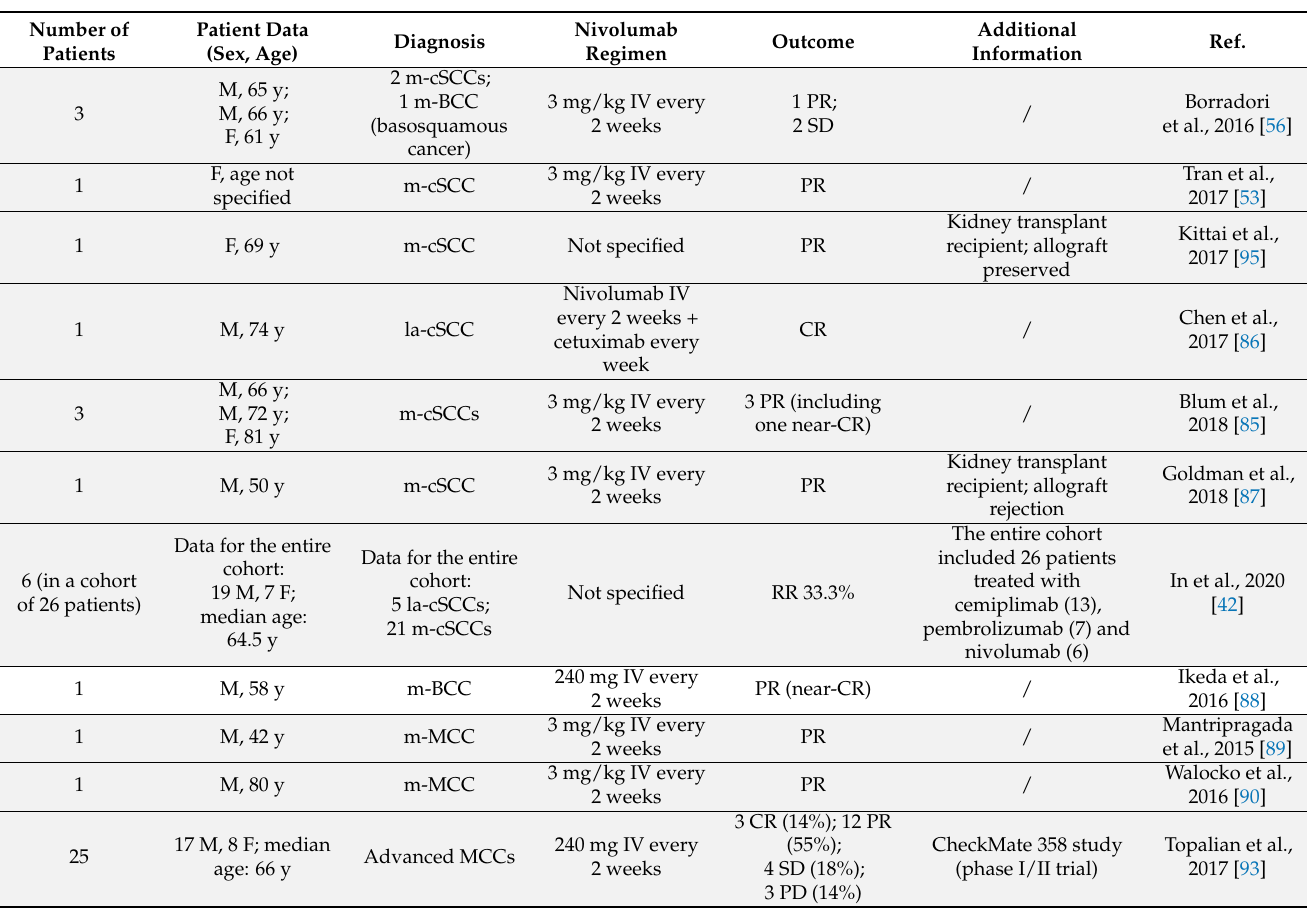
Table 4. Reported cases of locally advanced and metastatic non-melanoma skin cancers treated with